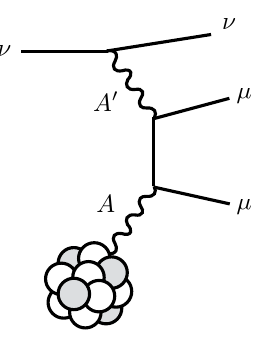
Figure 9 . Diagram for neutrino trident production of